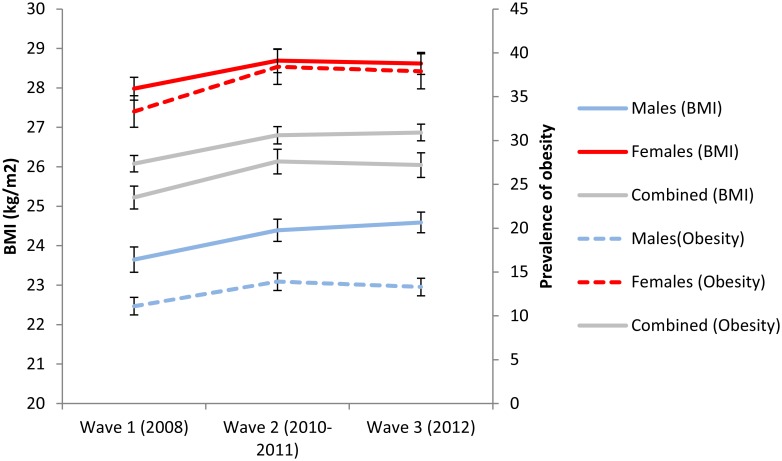
trends in BMI and obesity prevalence by gender and period.